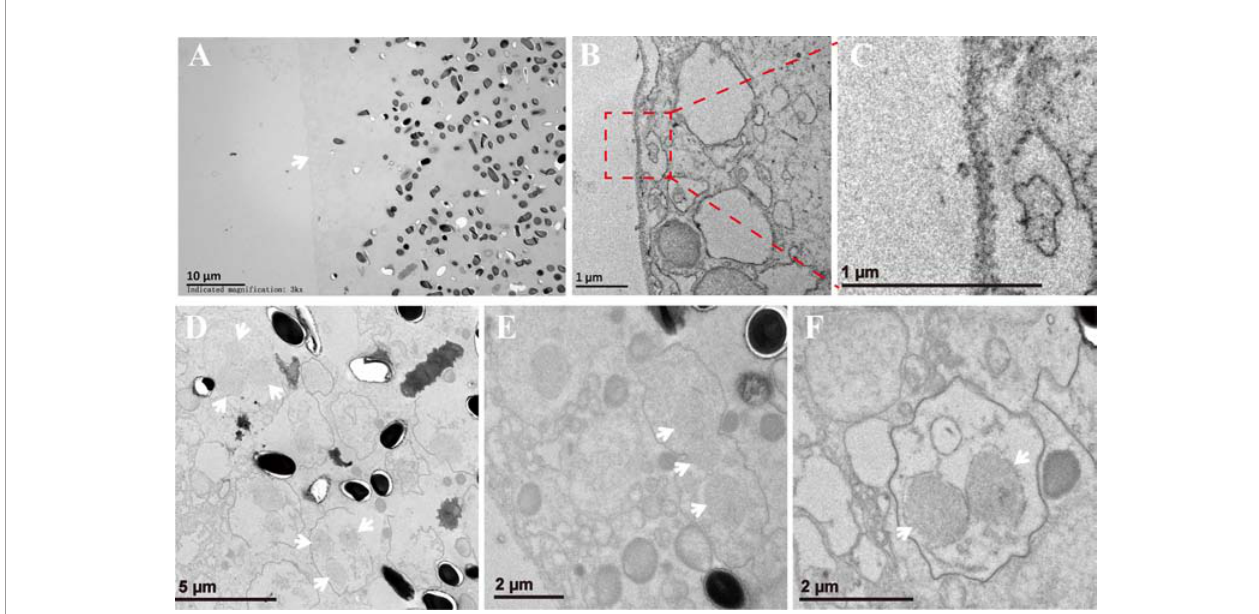
FIGURE 6 | The xenoma observed by TEM. (A) The outer wall of xenoma (arrowhead) and V. necatrix BM inside. (B, C) The magni fi ed outer wall of the xenoma. (D – F) The development of V. necatrix BM in xenoma. The arrowhead indicates the nuclei of the